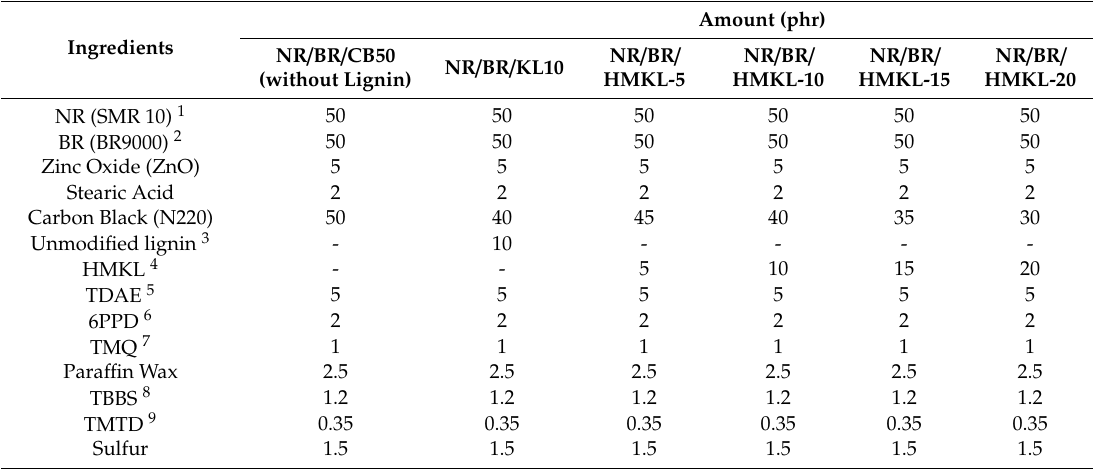
Table 1. Formulations of natural rubber / polybutadiene rubber (NR / BR) and modified or unmodified lignin used in this